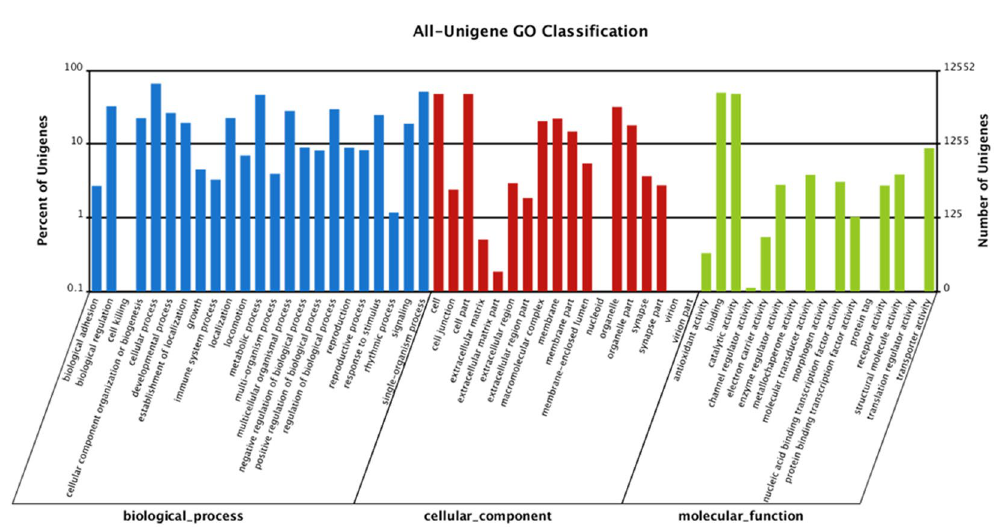
Figure 2. Functional annotation of Aphidius gifuensis antenna transcripts based on gene ontology (GO) categorization. GO analysis was performed at the level of two or three main categories (cellular component, molecular function, and biological